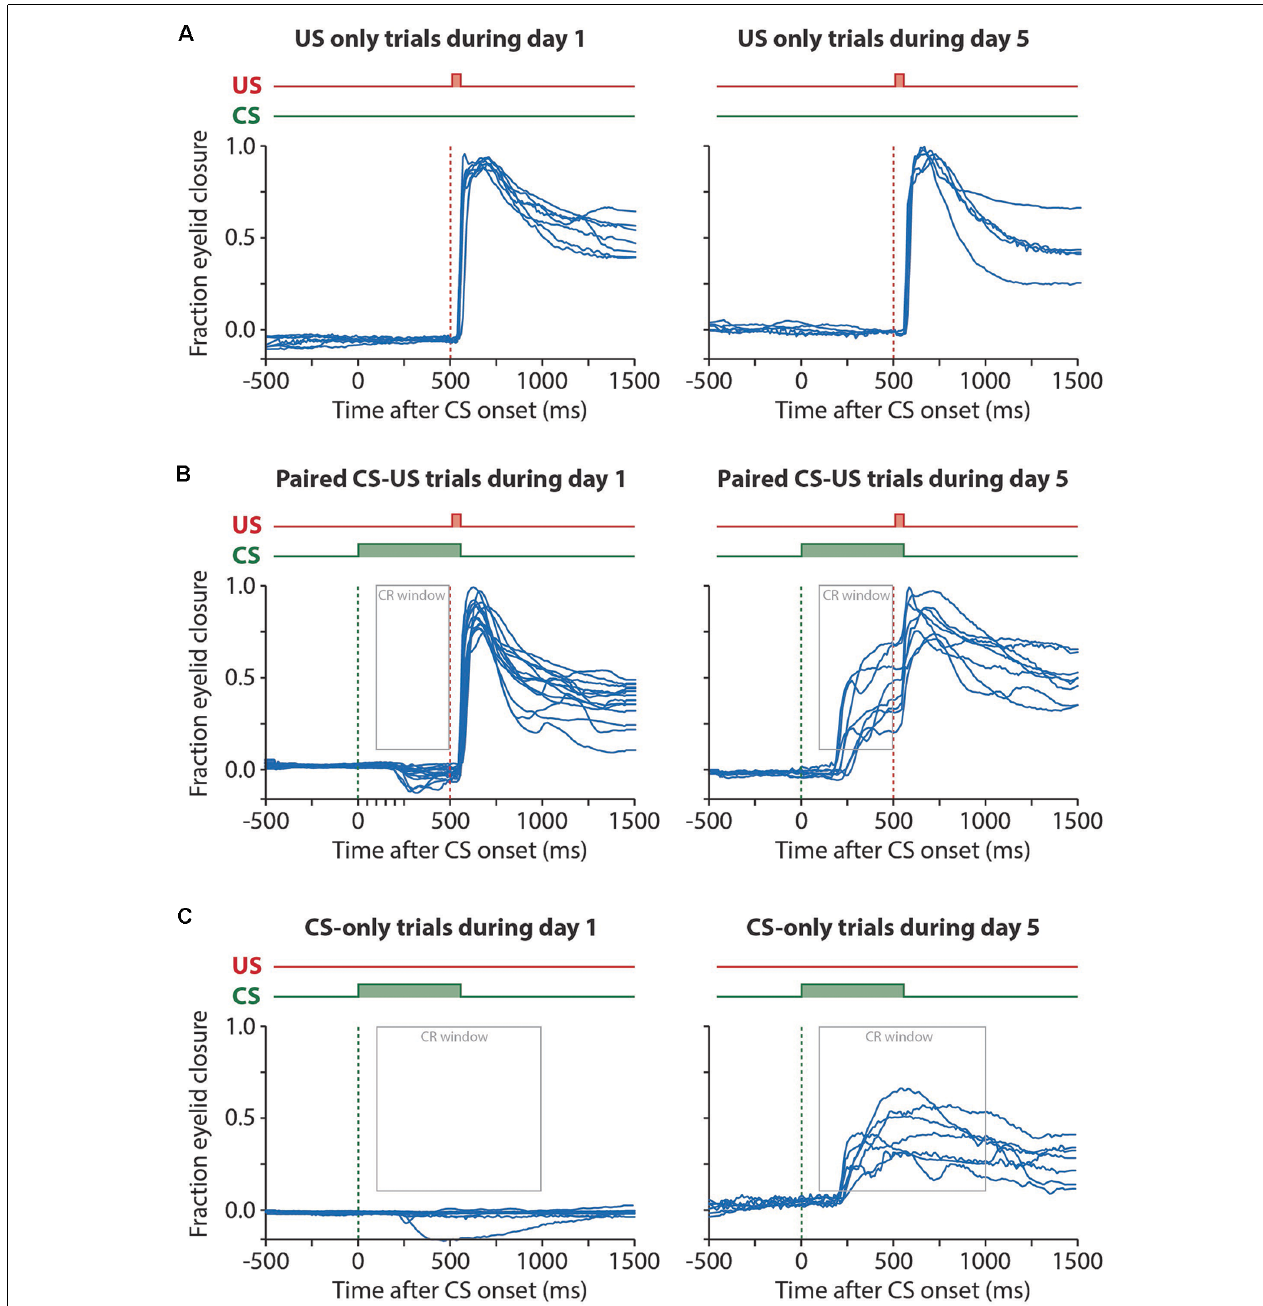
FIGURE 3 | Example raw eyelid responses in US-only, paired CS-US, and CS-only trials during session 1 and day 5. For all panels, the onset of the CS is marked with a green dashed line and the onset of the US with a red dashed line. (A) US only trials showing similar reflexive eyeblink, or “unconditional responses (UR)”, to the air puff during session 1 and session 5. (B) Paired CS-US trials showing no CRs during session 1 and large CRs during session 5. Note that the US still leads to a UR at the end of the training, masking the full kinetic profile of the CRs. Also, note that at day 1 there is a significant further opening of the eyelid in response to the CS (see Figure 2 ). The gray rectangle indicates the window that was used as a CR criterion. (C) CS only trials showing no CRs during session 1 and large CRs during session 5. Note that in CS only trials the full kinetic profile of the eyeblink CR is visible. Abbreviations: CS, conditional stimulus; US, unconditional